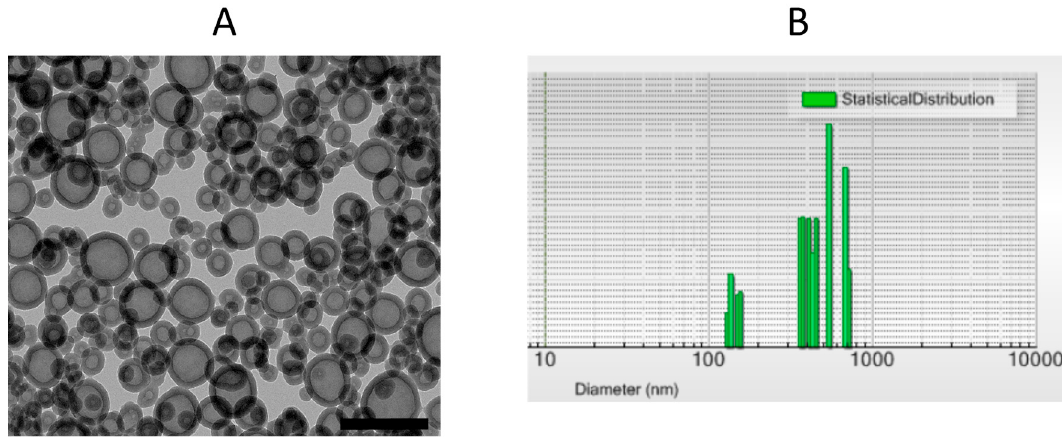
Figure 2. ( A ) TEM image of hollow organosilica nanoparticles (HOSNPs). Scale Bar 100 nm. ( B ) Dynamic light scattering in intensity mode of HOSNPs (dispersed in EtOH).